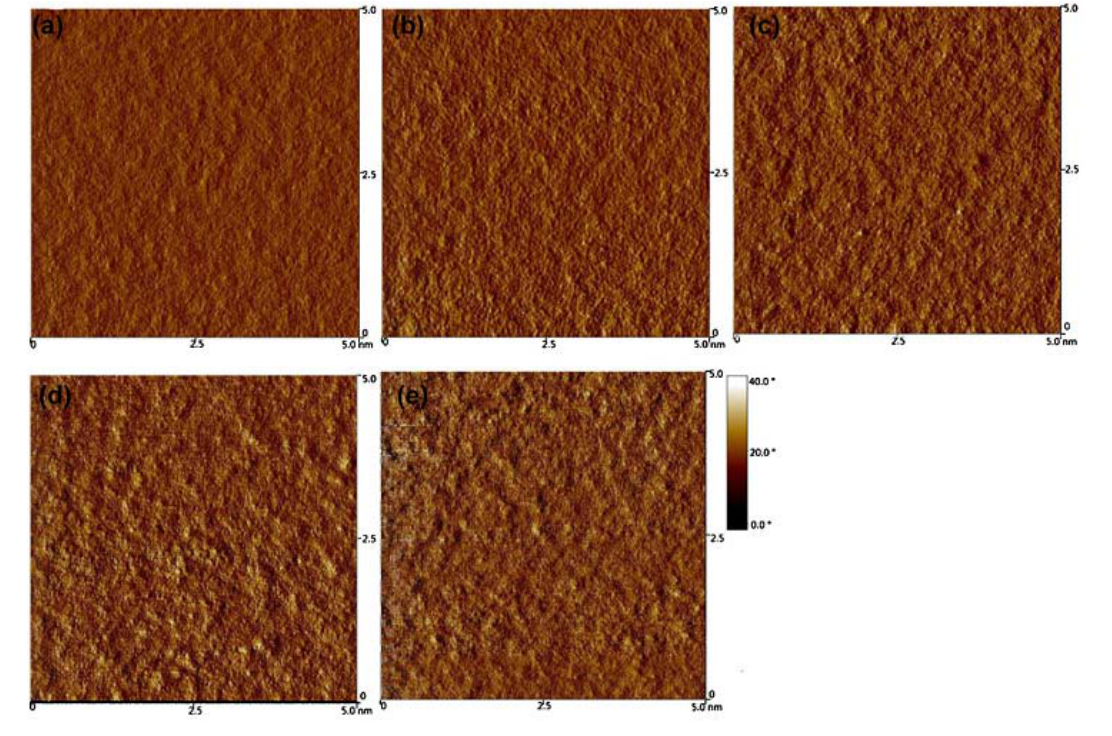
Figure 7. Atomic force microscopy (AFM) images obtained for PBDT-DTNT:PCBM films spin-cast from: ( a ) o -DCB solution; ( b ) o -DCB with 0.5% CN; ( c ) o -DCB with 1% CN; ( d ) o -DCB with 2% CN; and ( e ) o -DCB with 3% CN. Reprinted with permission from Elsevier